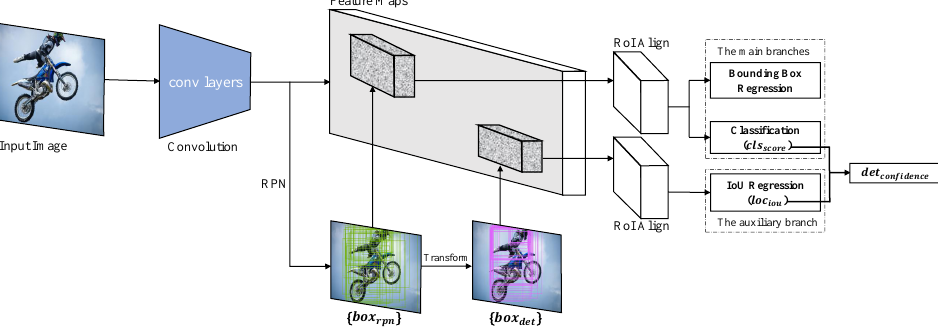
Figure 1. The framework of IoU-aware R-CNN. The main branches and the auxiliary branch are performed on { box rpn } and { box det } , respectively. The auxiliary branch estimates the localization quality and almost does not affect the original network of Faster R-CNN, which only changes the ranking confidence of the NMS process. Unless otherwise stated, we use class-agnostic IoU regression in a simple